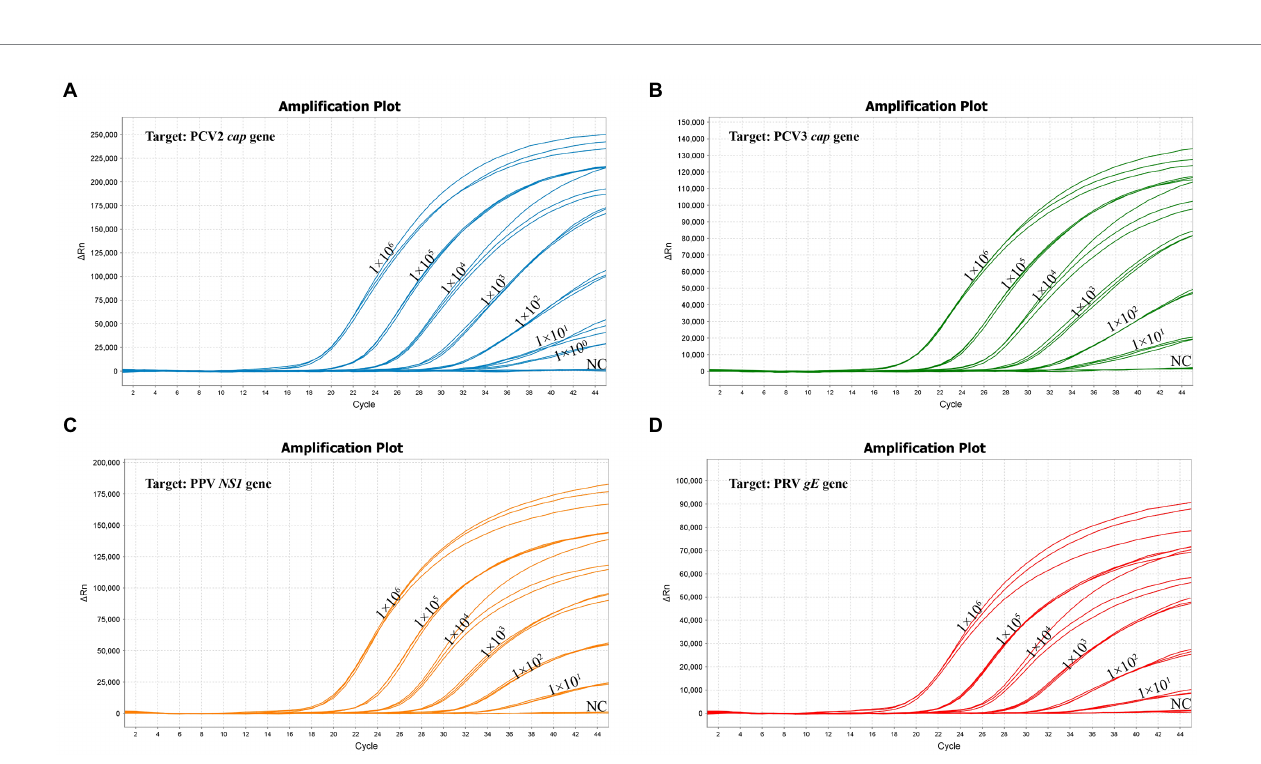
FIGURE 5 The sensitivity of multiplex real-time PCR assay. (A) The sensitivity for the PCV2 cap gene. (B) The sensitivity for the PCV3 cap gene. (C) The sensitivity for the PPV NS1 gene. (D) The sensitivity for the PRV gE